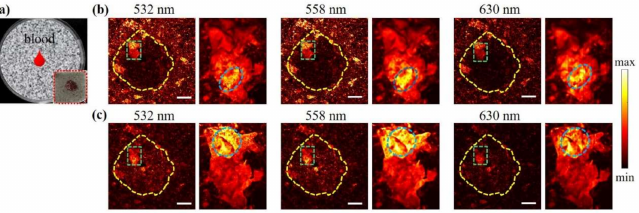
Figure 5. In vitro OR-PAM imaging results. ( a ) Schematic illustration of the evaluation model. ( b ) PAM images at indicated wavelength. ( c ) PAM images at 50 µ m lower imaging depth. The scale bar is 0.5